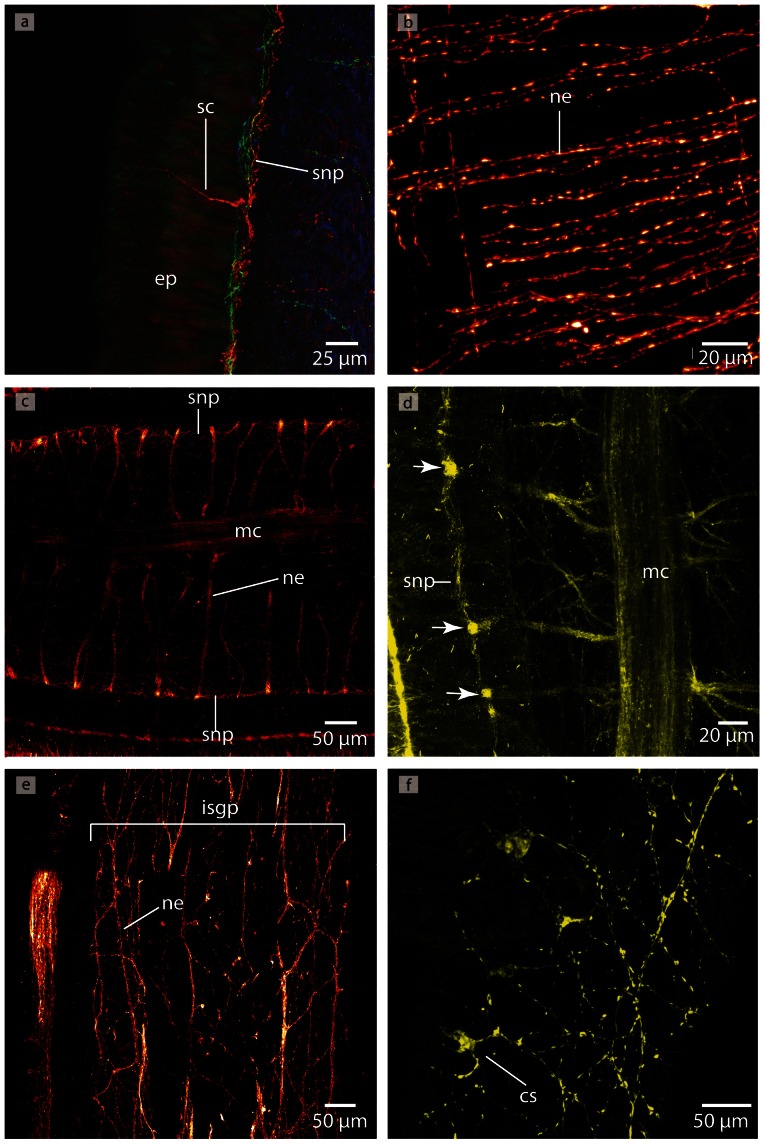

Carinina ochracea, confocal laserscanning (cLSM) micrographs of differently immunostained vibratome sections.
a: Anti-FMRF, horizontal section. A sensory cell (sc) originates in the subepidermal plexus (snp) and proceeds into the epidermis (ep). b: Anti-FMRF, horizontal section. The neurites (ne) of the intraepidermal nerve plexus are arranged in a ladder-like manner. c: Anti-α-tubulin, sagital section. The lateral medullary cords (mc) are interconnected to the subepidermal plexus (snp) by branches of neurites (ne). d: Higher magnification of c. Note the concentration of neurites in the subepidermal nerve plexus (arrows) e: Anti-FMRF, horizontal section. The neurites (ne) of the intrastomatogastric nerve plexus are irregular arranged. f: Anti FMRF, horizontal section. Multipolar neurons (cs) are distributed in the intraepidermal nerve plexus.